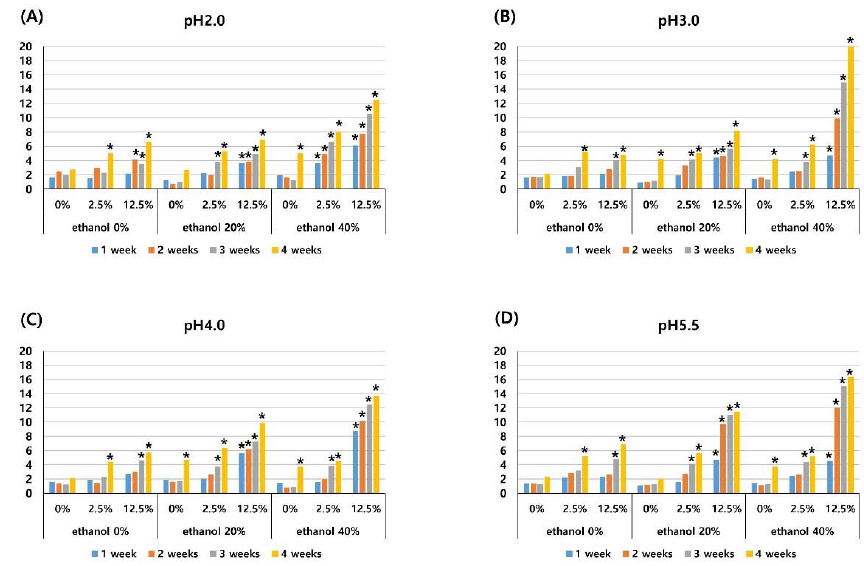
Figure 2. Mean color changes ( Δ E) of the composite resin after different periods of storage (1 ‐ , 2 ‐ , 3 ‐ , and 4 ‐ weeks) in media of pH 2.0 ( A ), pH 3.0 ( B ), pH 4.0 ( C ), pH 5.5 ( D ) with three different pigment concentrations (0%, 2.5%, 12.5%), and three different ethanol concentrations (0%, 20%, 40%). An asterisk (*) represents a clinically noticeable color change ( Δ E > 3.3). The translucency parameter (TP) decreased as the storage period increased, and this change was 2.5% pigment significantly decreased the TP compared to a solution with 0% pigment ( P = 0.001). The solution with 12.5% pigment significantly decreased the TP when compared with both the solution with 0% pigment ( P < 0.001) and the solution with 2.5% pigment ( P = 0.002), as shown in Table 2. The TP did not change significantly according to the pH or ethanol concentration of the solution. The mean TP in each experimental solution is presented in Figure 3.